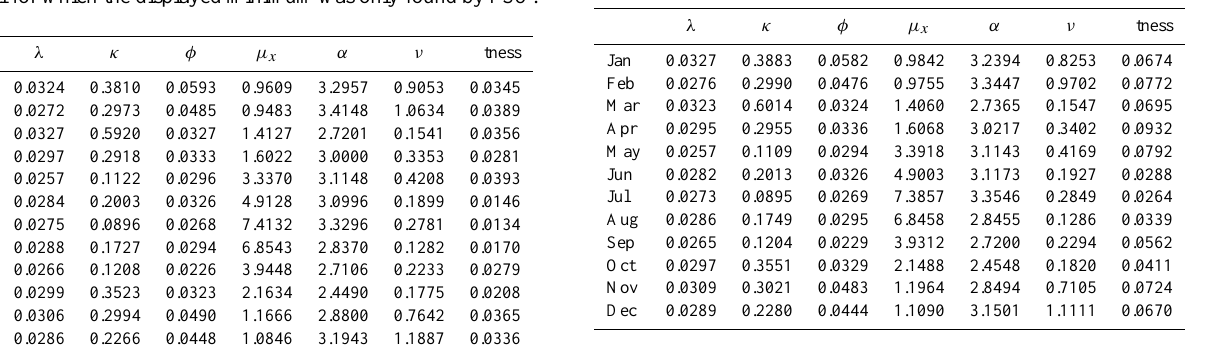
Table 7. Final parameters resulting from calibration with OF2 found by each of the optimization